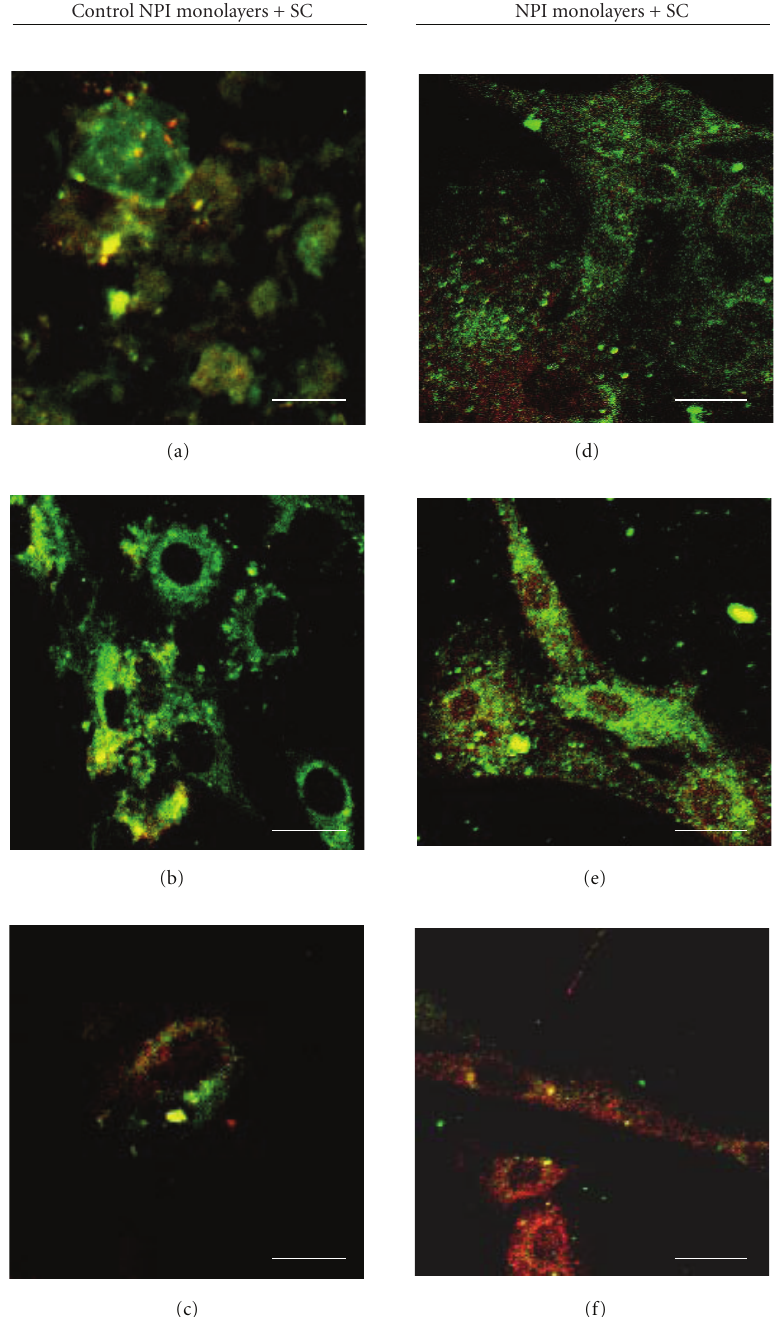
Figure 5: Double fluorescence immunolabeling (green signal: anti-PDX-1 Ab; red signal anti-insulin Ab) under confocal laser microscopy of NPI cell monolayers cultivated for 7 (a), (d), 14 (b), (e), and 21 (c), (f) days, alone (a)–(c) or with SC (d)–(f). Bar = 10 μ